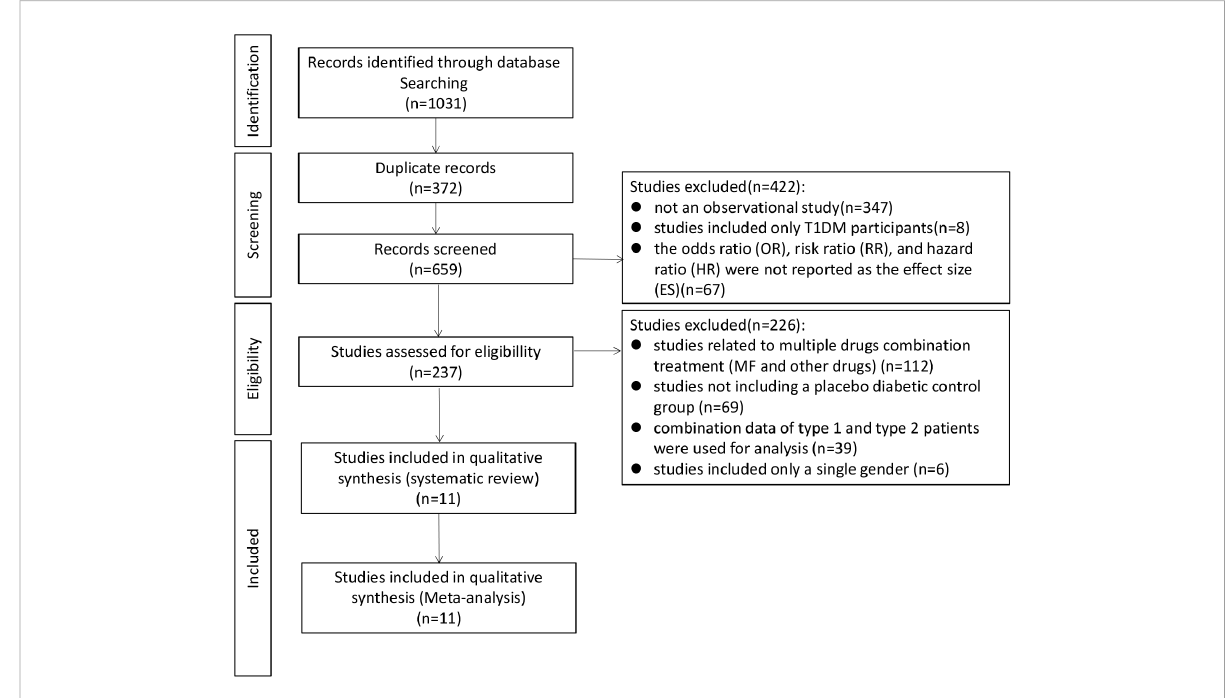
FIGURE 1 Flowchart of the study selection